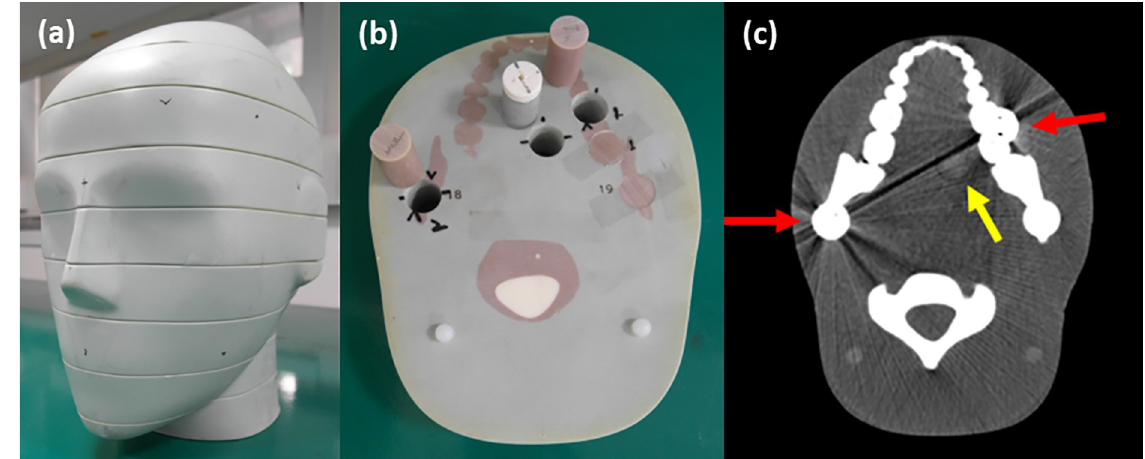
Fig 5. (a) Adult male ATOM head phantom (ATOM phantom) that artificially generates metal artifacts and targets iodine-enhanced oral tumor. (b) Two metal implants and iodine were inserted into the ATOM phantom. (c) Image for the 30 to 140 keV energy level. We placed two metallic implants, one on the left, and the other on the right region of the lower jawbone (red arrow); iodine-enhanced tissue (yellow arrow) is located between them. Display window: W/L = 600/150 HU.